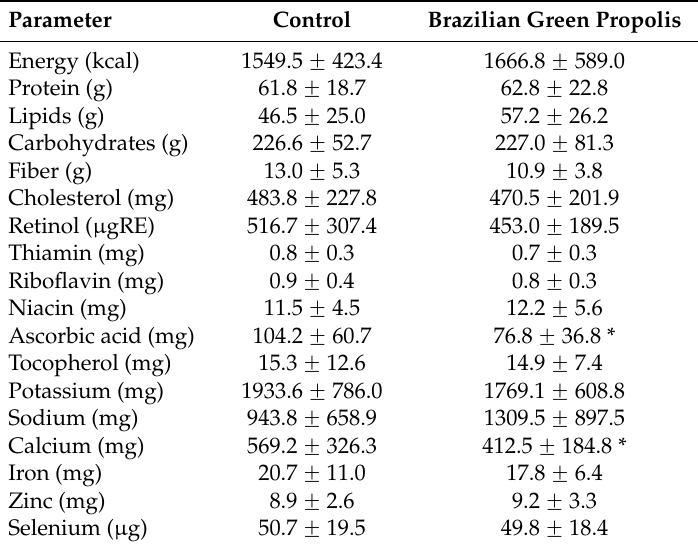
Table 2. Results of dietary survey ( x ˘